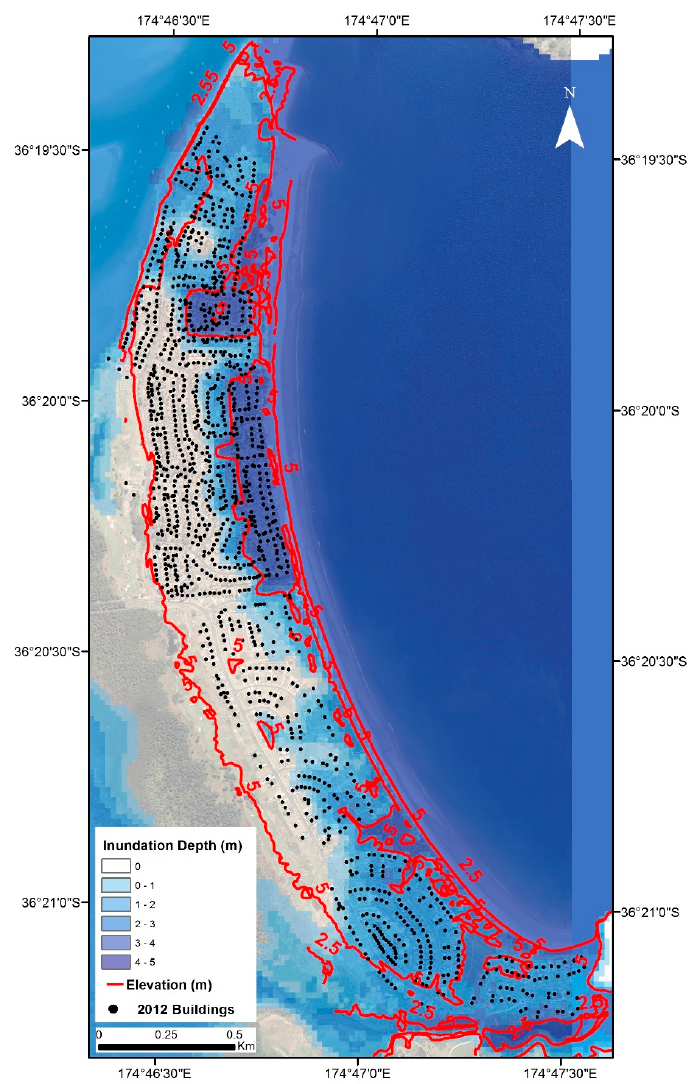
Figure 2. Modelled maximum tsunami inundation extent at Omaha Beach.